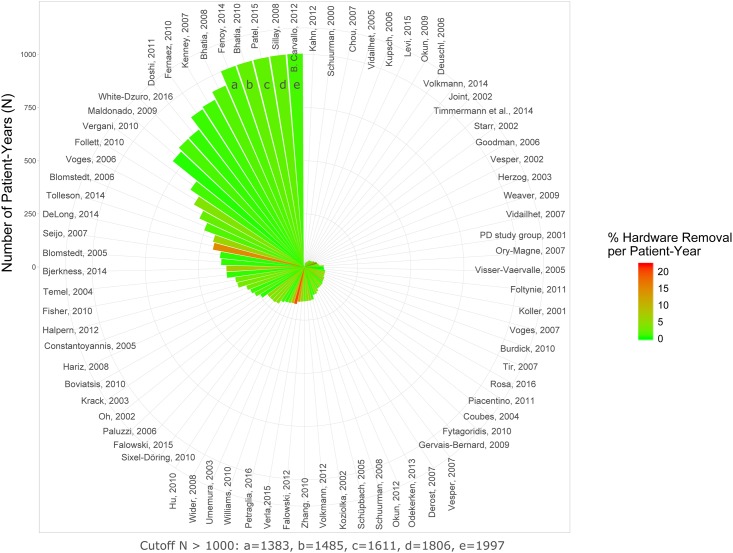
Percent hardware removal per patient-year.The rate of AEs is color-coded. The number of patient-years calculated for individual studies is indicated by the height of the wedges (cutoff value 1000 patient-years).